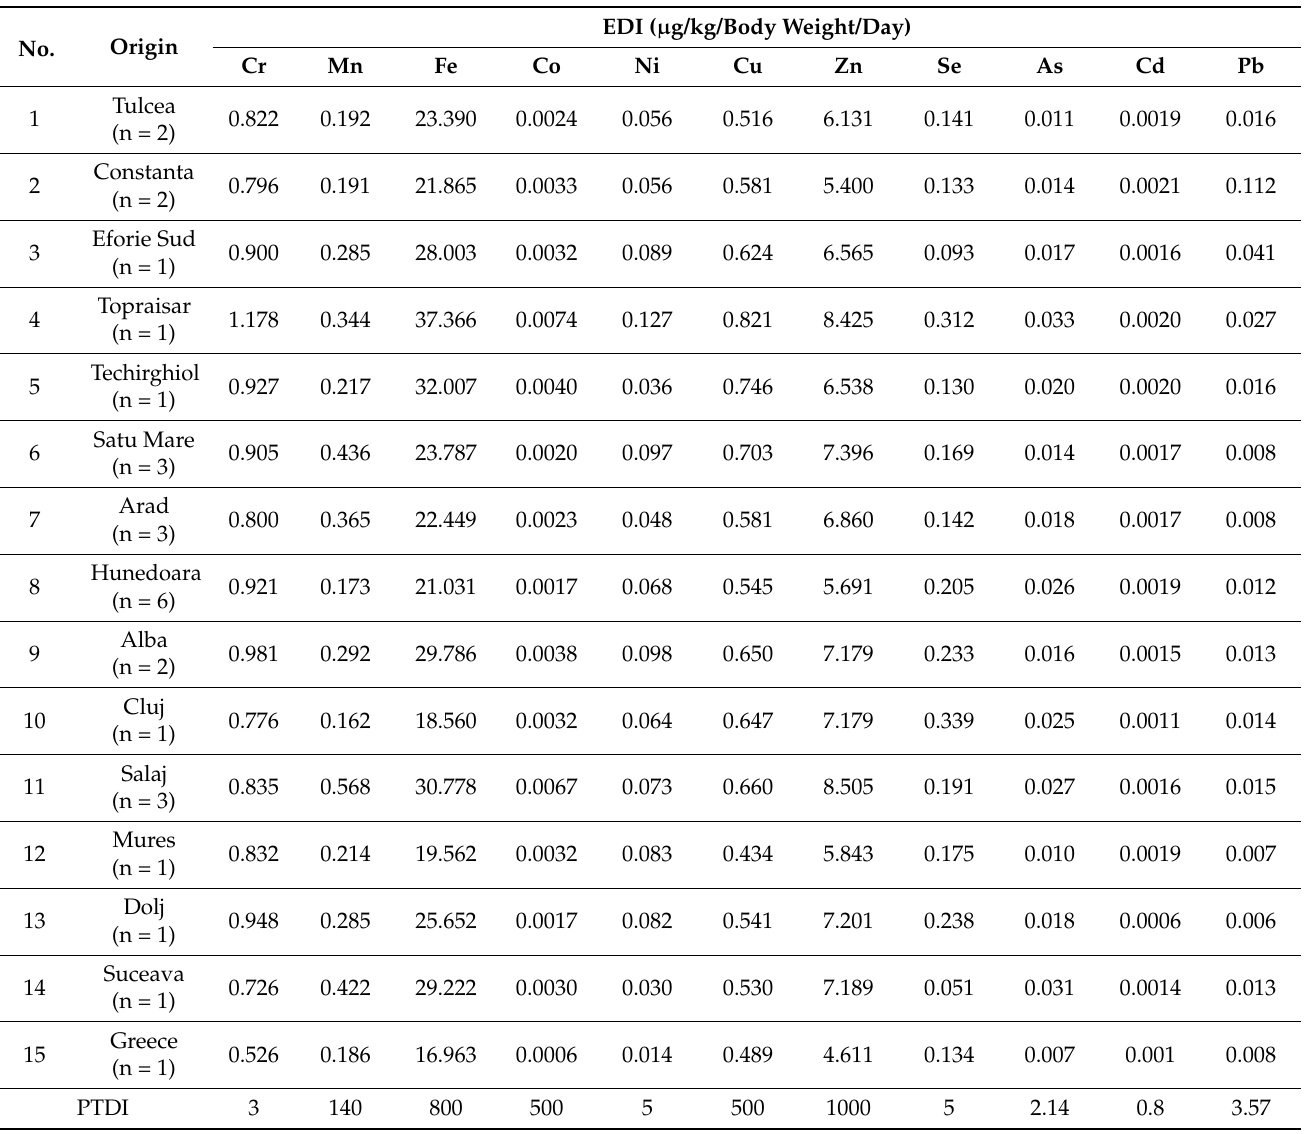
Table 4. Estimated dietary intakes (EDI) of investigated elements by consumption of eggs in different regions and provisional tolerable daily intake